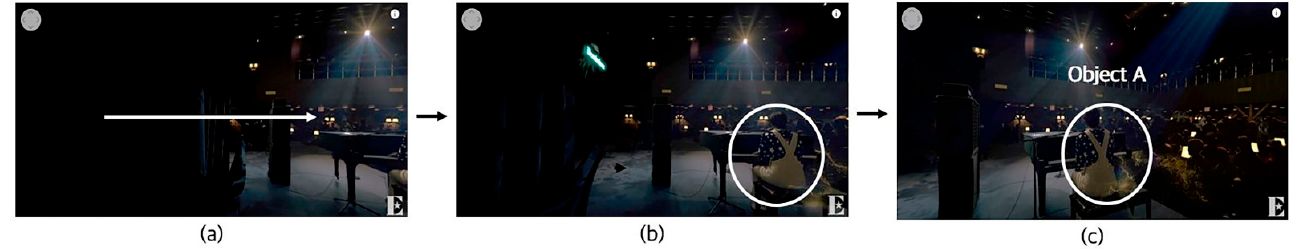
object B plays, in the position intended by the director, as shown in Figure 7f. Figure 6. Directed Case 1 using “camera movement” (video No. 23). ( a ) The camera moves in the direction of the marked arrow, ( b ) The user's attention moves to the right along the camera's movement, ( c ) The user can see the scene where object A plays the piano in the location intended by the director.